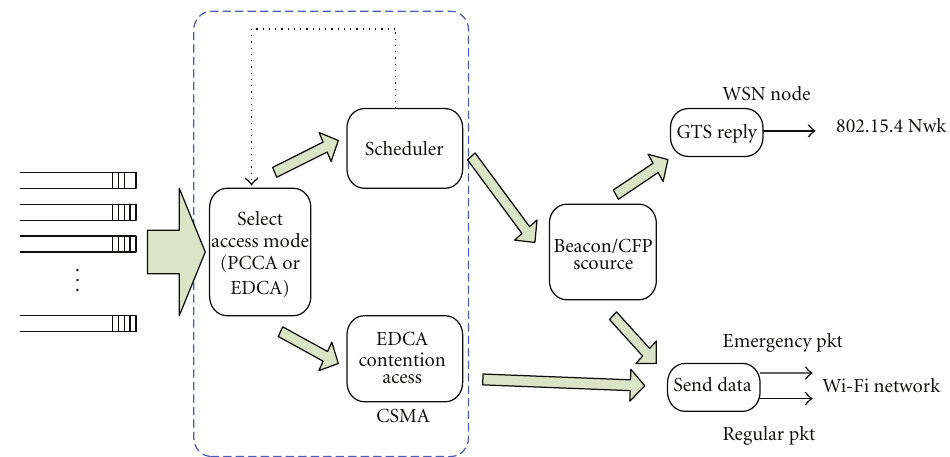
Figure 10: Queuing model in the WSN Coordinator.